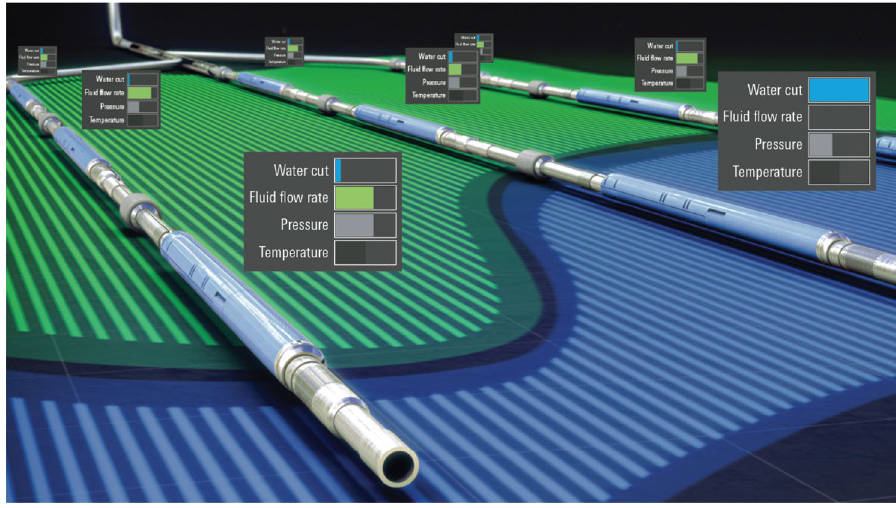
Fig. 3 Manara real-time